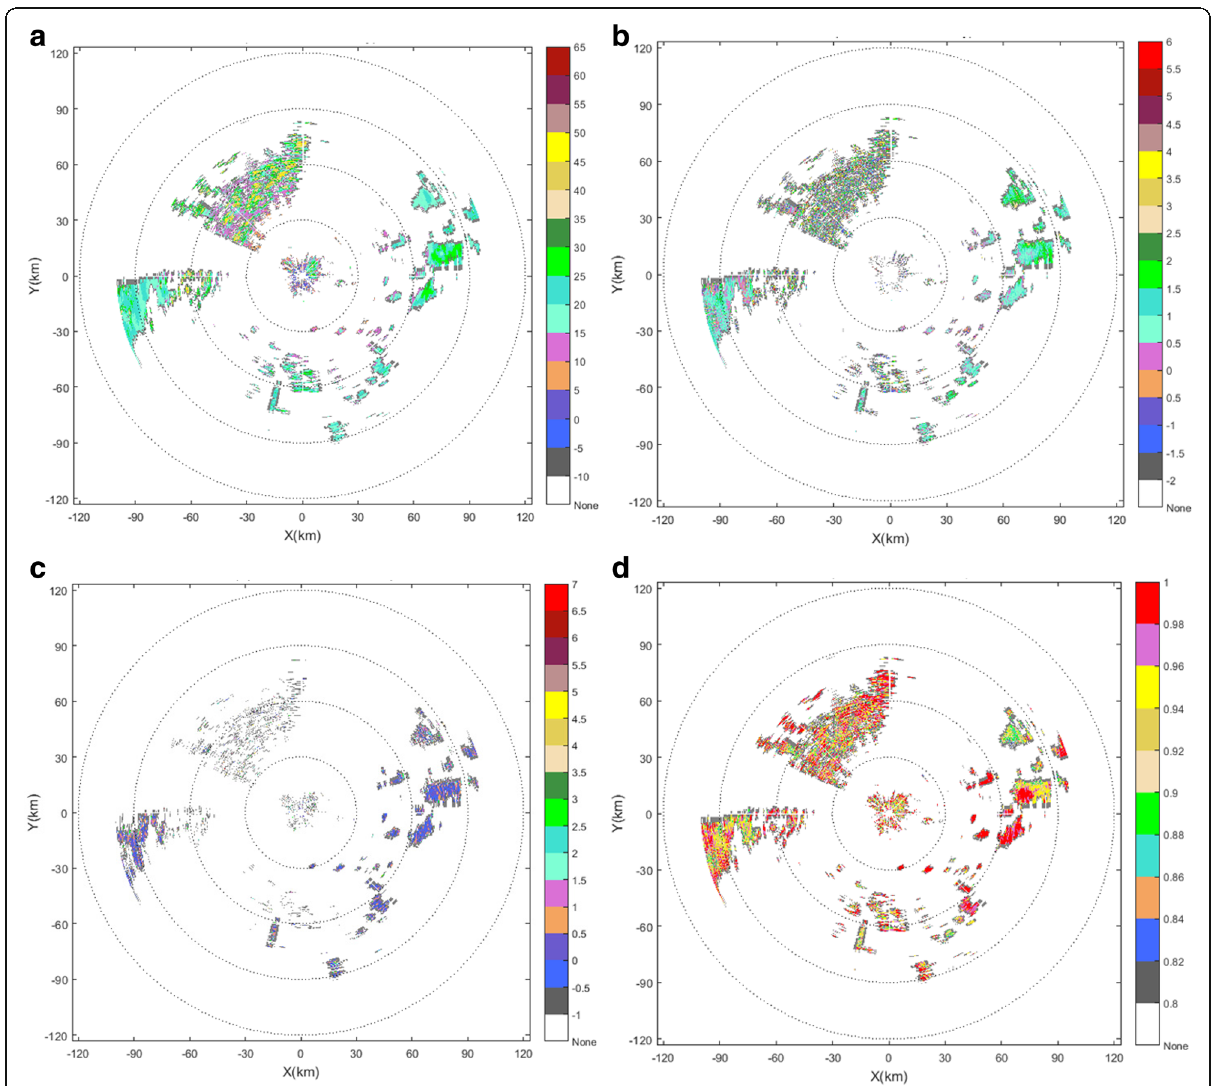
Fig. 4 The radar measurements corresponding to the case of 27 March 2017. a Z H . b Z DR . c K DP . d ρ